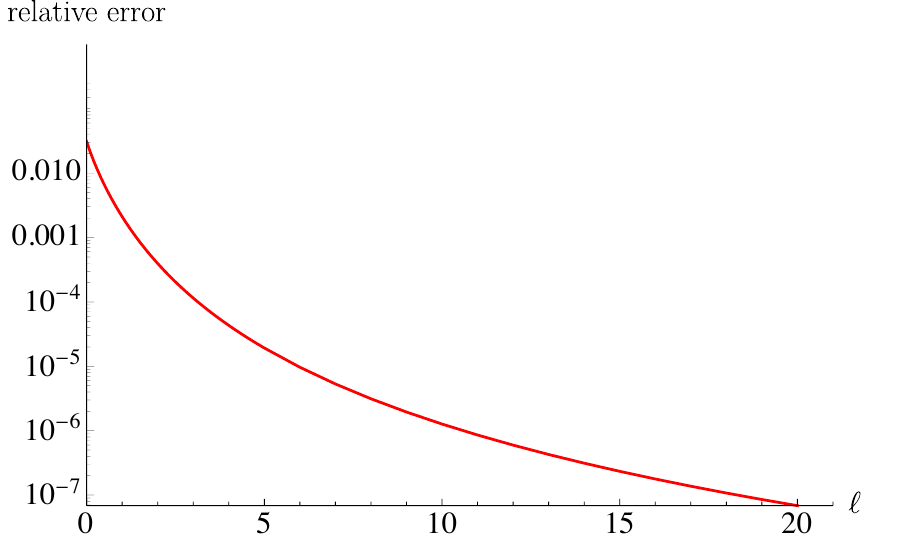
Figure 21 . A comparison between two di(cid:11)erent expansions in charge 3 even-spin sector. We evaluate the relative error